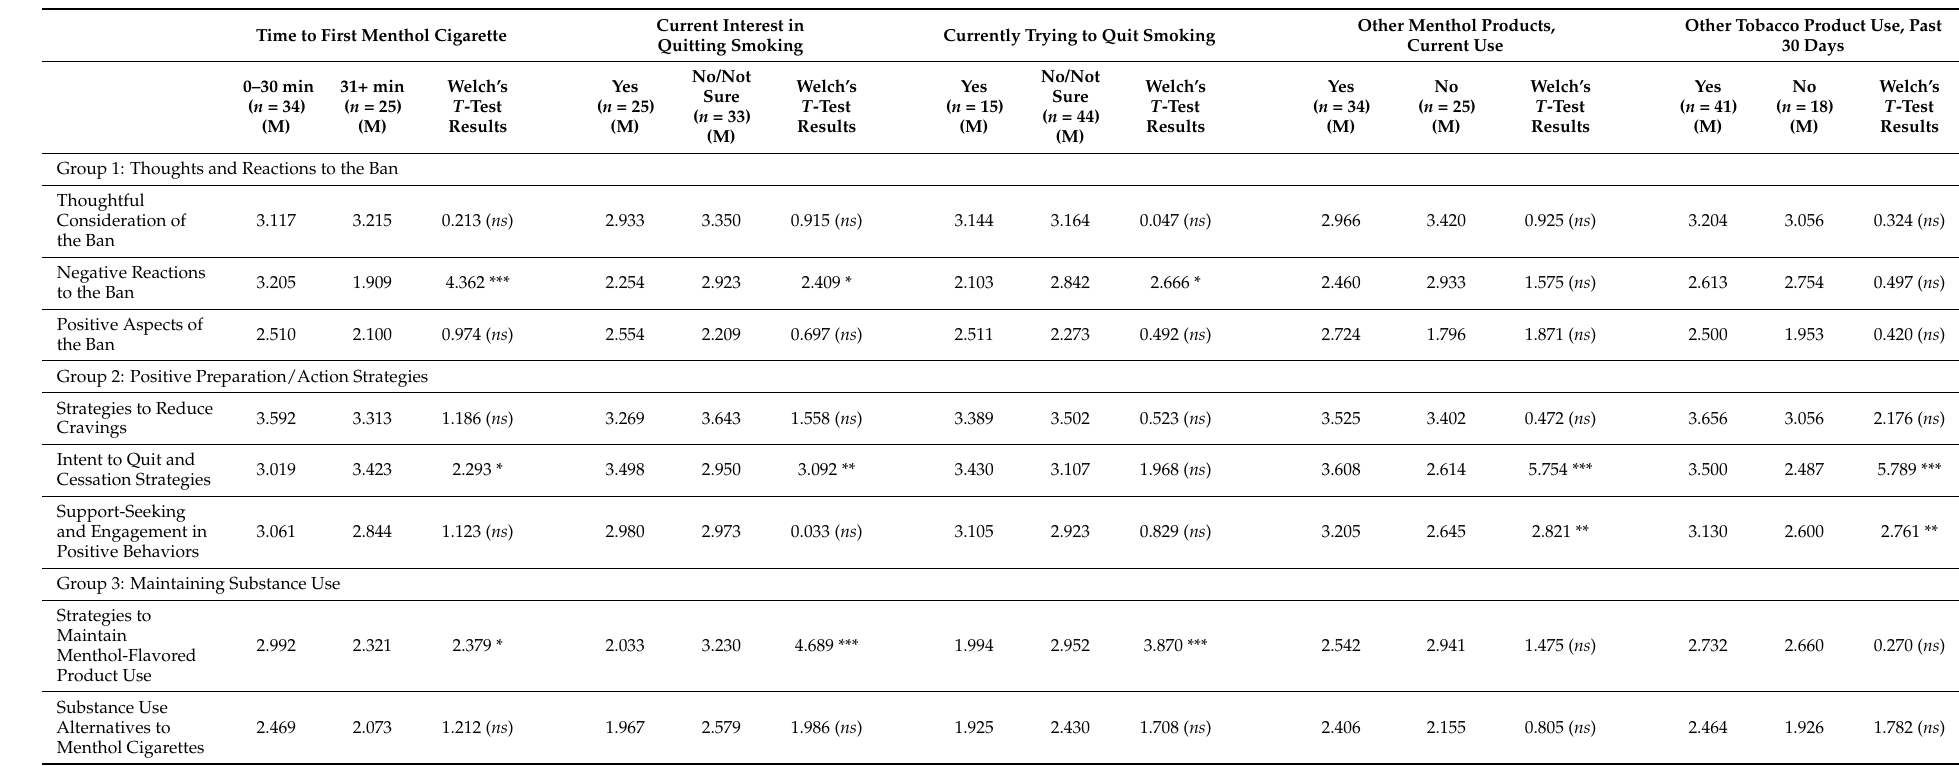
Table 3. Welch’s t -test results for tobacco use and cessation intention by cluster group and